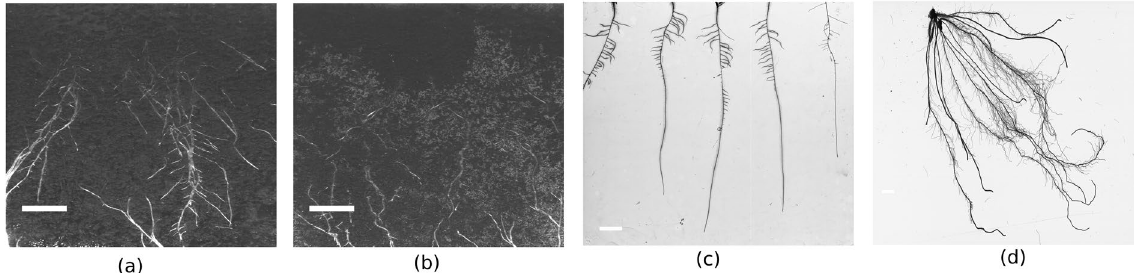
Figure 1. Examples of root images from different setups: ( a ) Arabidopsis plant roots 28 days after sowing, ( b ) Arabidopsis plant roots with condensation noise 28 days after sowing, ( c ) roots grown in agar, ( d ) washed roots. The white color bar on each image represents the scale of 1 cm